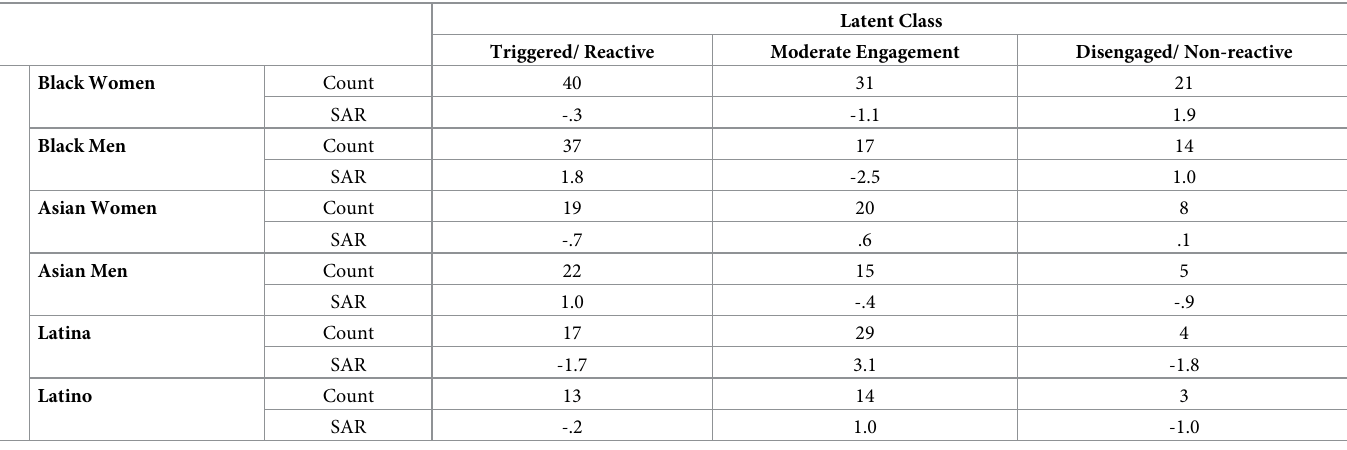
Table 5. Cross-table of race by gender groups and three latent